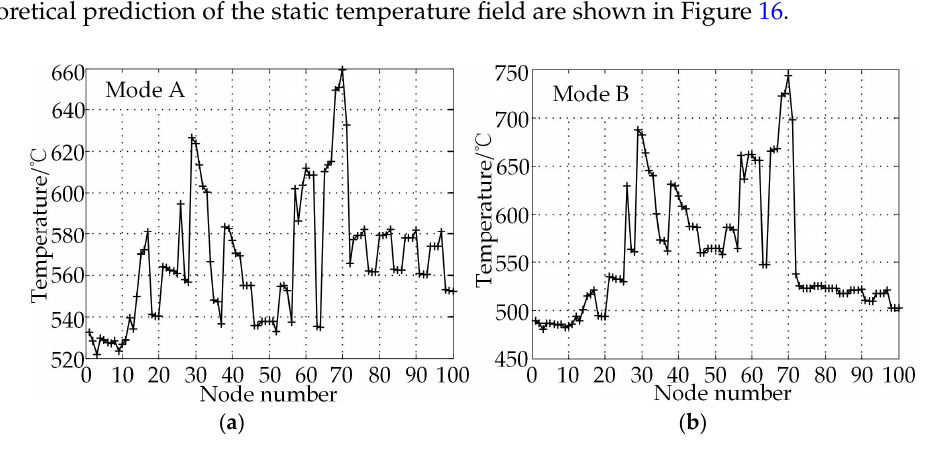
Figure 16. Static temperature field of mode A ( a ) and mode B ( b ).